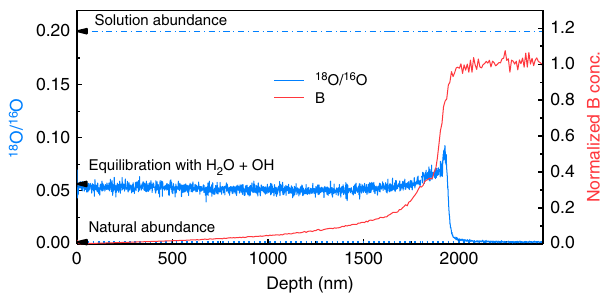
Fig. 7 Dynamics of reorganization of a mature gel. Oxygen isotopic ratio and B pro fi les recorded by ToF-SIMS depth pro fi ling on a piece altered 1625 days (experiment 3) in the initial experiment and then placed 1 month in similar conditions (90 °C, pH 90°C 7, silica-saturated solution) with water spiked with 18 O ( 18 O/ 16 O = 0.24). During this 1-month experiment, the oxygen isotopic signature of the gel raised from natural abundance to 0.125 on average, leading to a fraction of exchanged O of